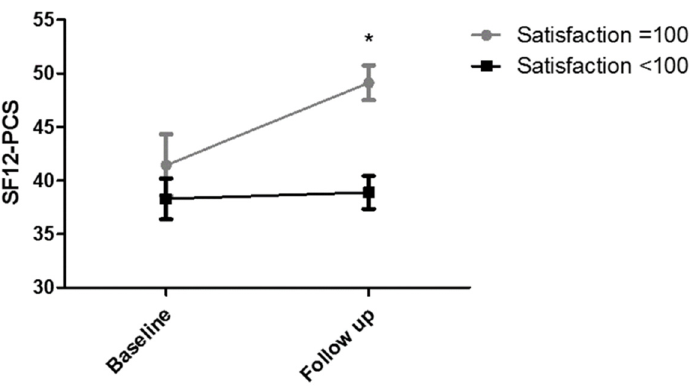
Figure 1. SF12-PCS improvement in patients scoring 100 (maximum) in the satisfaction questionnaire and in patients scoring less than 100. * p < 0.05 between groups.